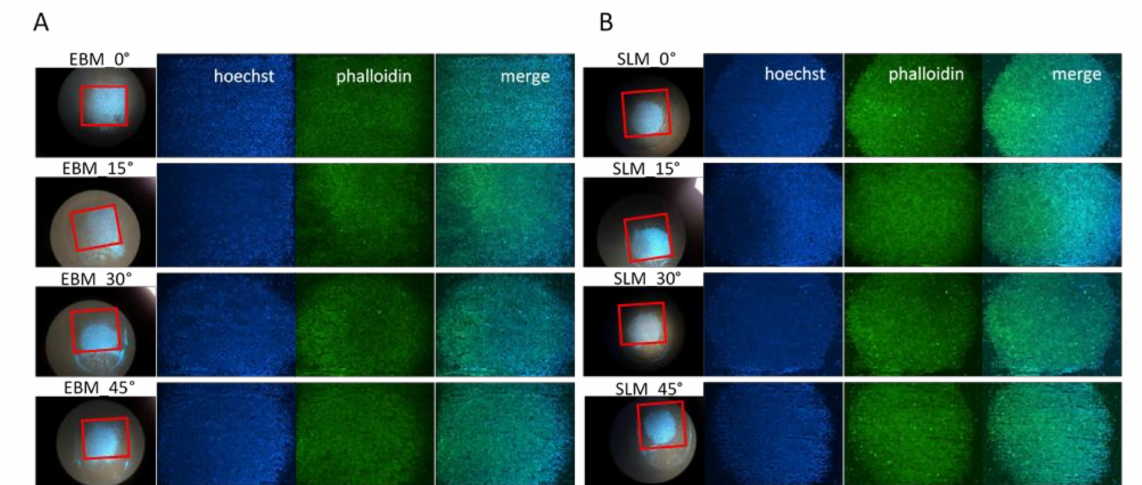
Figure 7. Fluorescence microscopy images of MC3T3-E1 cells after 7 days in culture on EBM ( A ) and SLM ( B ) titanium sca ff olds (phalloidin in green, nuclei in blue, 2x), with a detailed photograph of the entire sca ff olds delimited by a red square to indicate the area covered by the